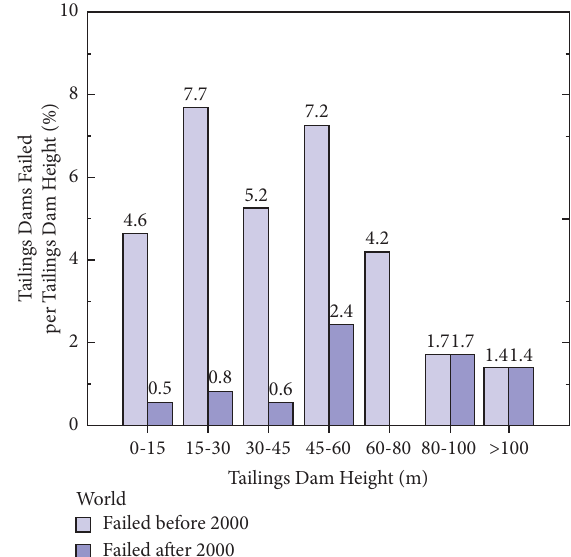
Figure 18: Percentage of tailings dams failed per height in the world, before and after 2000 (data from Bowker [22] and Torrez- Cruz [32]).